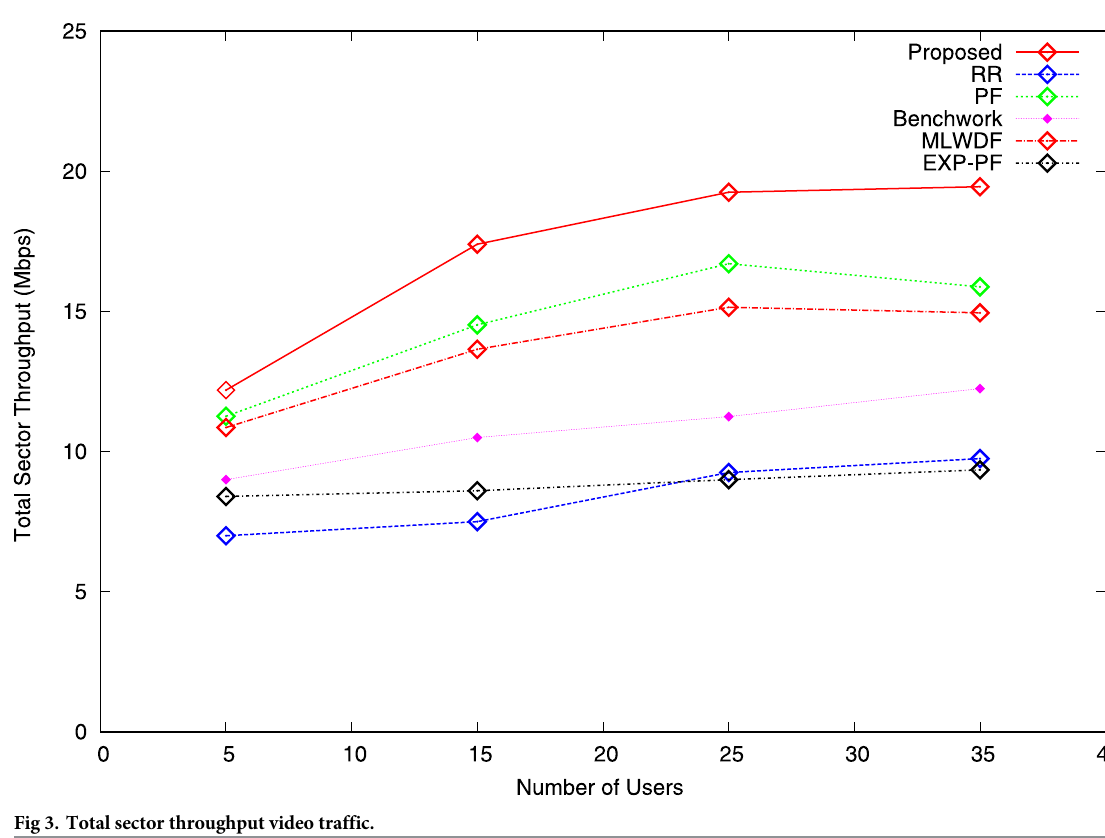
Fig 3. Total sector throughput video